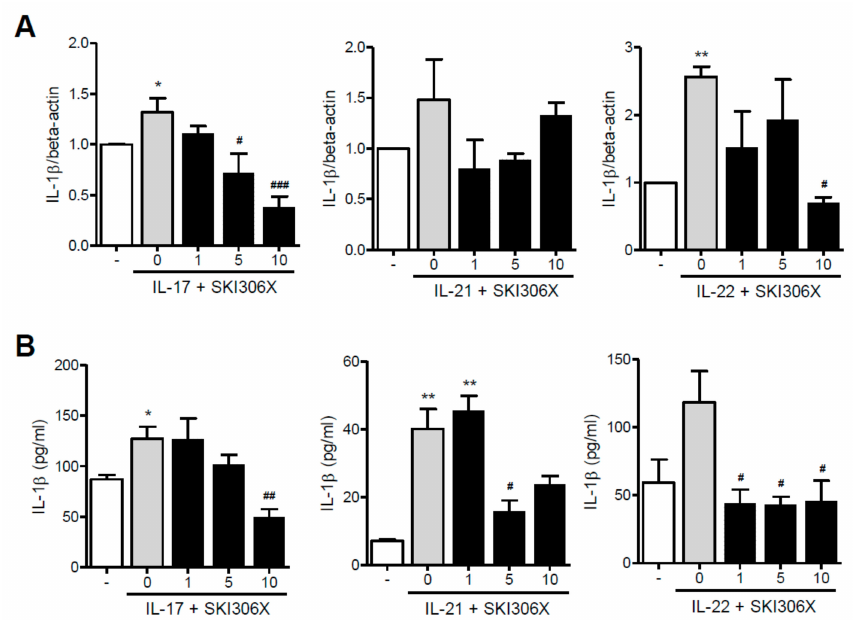
Figure 2. The inhibitory e ff ect of SKI306X in Th17 cytokine-induced IL-1 β expression and production in synovial fibroblasts in RA. ( A ) RA synovial fibroblasts were cultured in medium supplemented with IL-17, IL-21, and IL-22 with various concentrations of SKI306X, and IL-1 β expression was examined using real-time PCR, normalized to beta-actin and reported in relative expression units. ( B ) RA synovial fibroblasts were cultured in medium supplemented with IL-17, IL-21, and IL-22 in the presence of various doses of SKI306X, and IL-1 β production in the culture media was determined via ELISA. The data represent mean ± SD values from six independent experiments. * p < 0.05 and ** p < 0.01 compared with the nil condition (white bars). # p < 0.05, ## p < 0.01 and ### p < 0.001 compared with the Th17 cytokine stimulating condition (gray